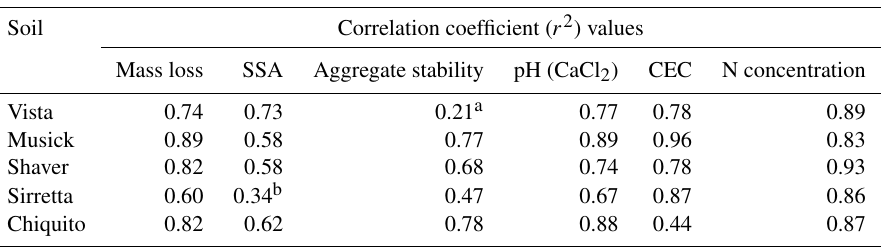
Table 3. Linear correlation coefficients of changes in soil properties with changes in C concentration. All correlation coefficients have p values < 0.01 unless otherwise